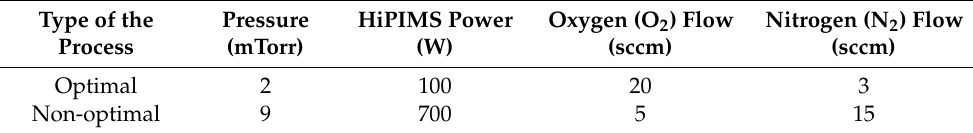
Table 2. Experimental runs of the HiPIMS process designed for the verification of the electrical properties of HfO x N y films.